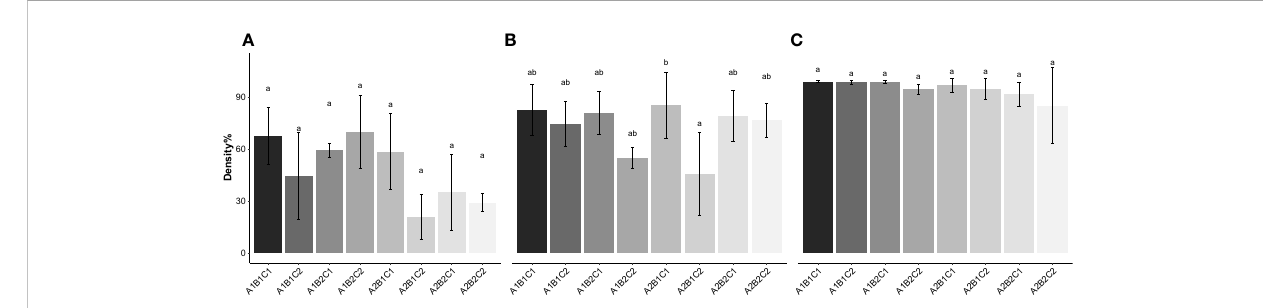
FIGURE 3 Seedling density (%) of S. latissima (means ± SD) on day 16 (A) , 23 (B) and 37 (C) cultured on different substrate (A1: Natural; A2: Arti fi cial), water velocity (B1: 0.1 m s -1 ; B2: 0.2 m s -1 ) and spraying technique (C1: water; C2: water+binder); bars with different letters are signi fi cantly different (p< 0.05), n =